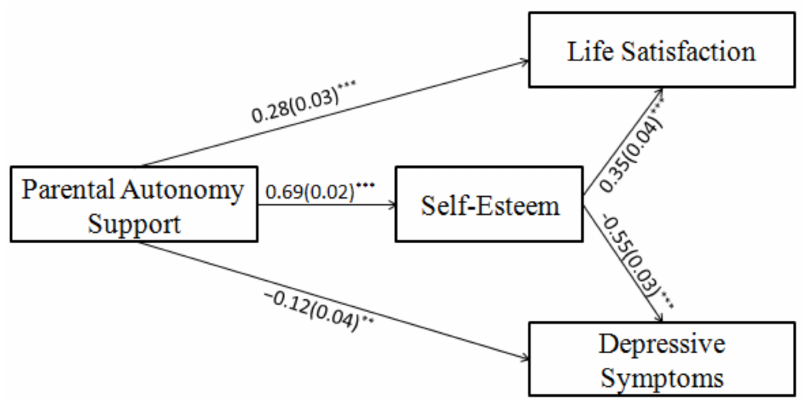
Figure 3. Mediation model for Study 2. Note. N = 1274. Standardized path coefficients and standard errors (inside the brackets); ** p < 0.01, *** p <